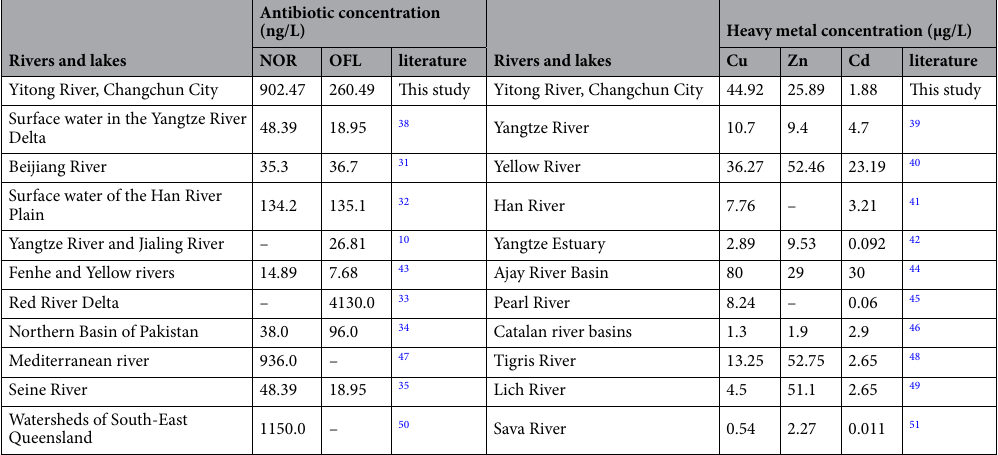
Table 1. Comparison of antibiotic and heavy metal concentrations in surface water of rivers and lakes at home and abroad. "–" indicates that the class of substances were not detected.